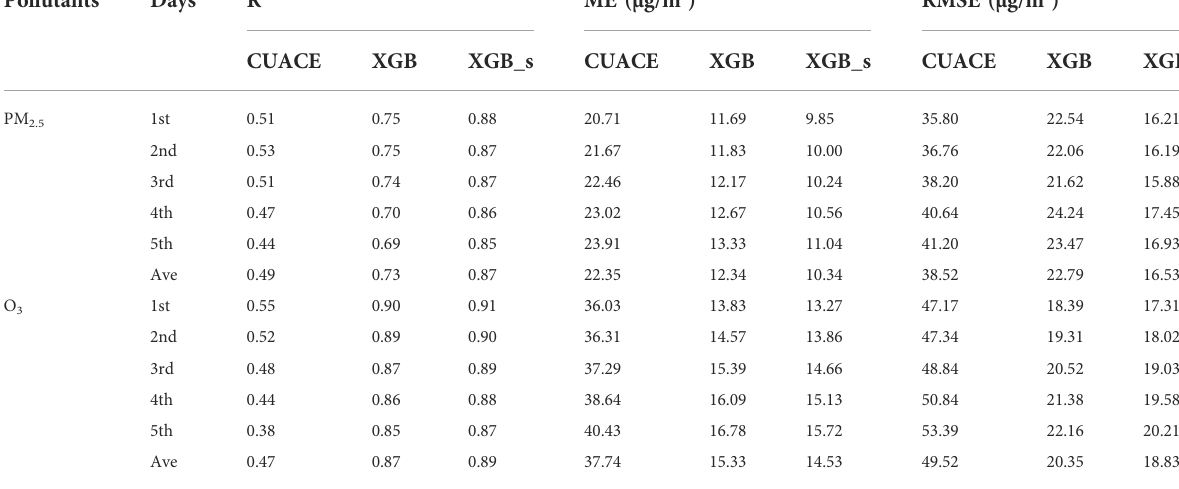
TABLE 2 Statistics of evaluation criteria for different pollutants and forecast